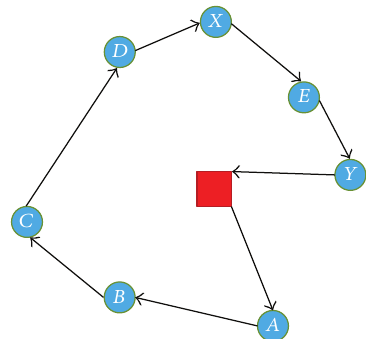
Figure 4: Previous route changed to meet new requests given to the traveling salesman.